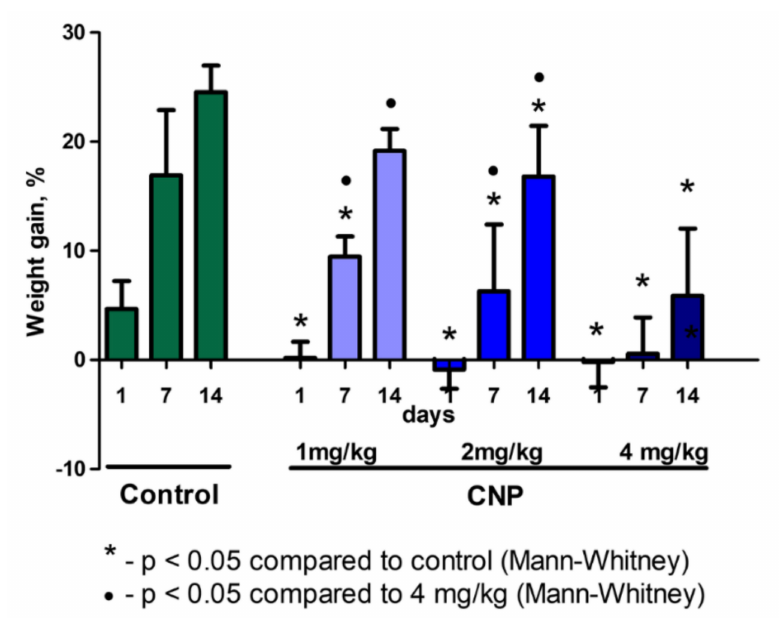
Figure 6. Dynamics of body weight after intravenous administration of CNPs (% of the baseline). The Mann–Whitney test was used to assess the significance of di ff erences between groups. Data shown are median ± range.